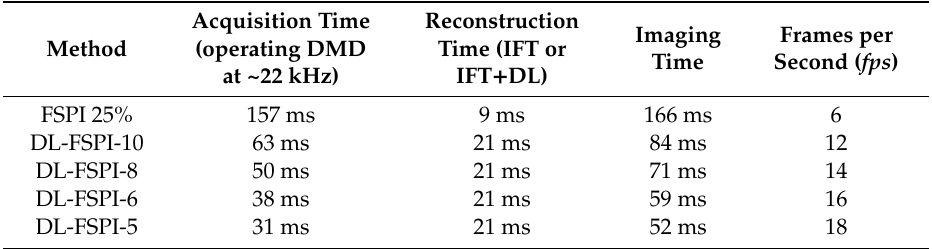
Table 1. Experimntal Imaging time for FSPI and DL-FSPI.